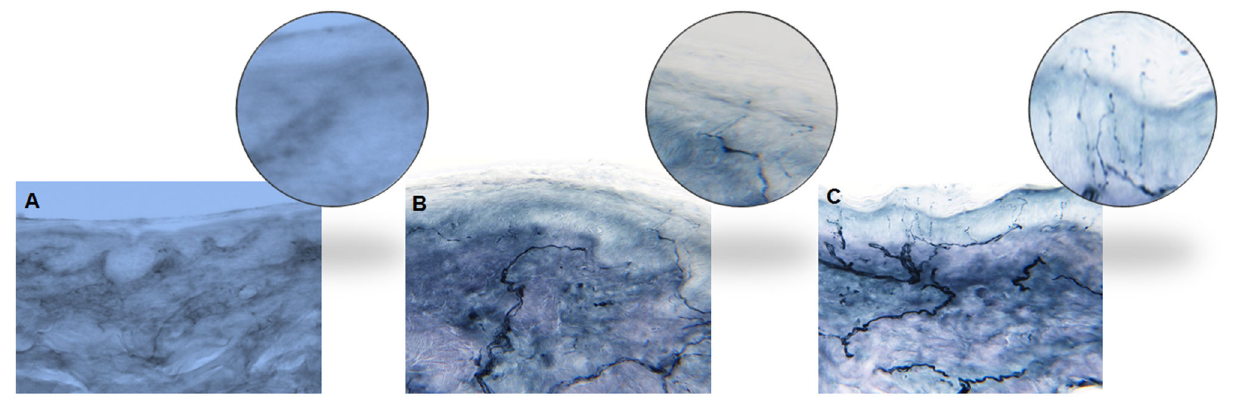
Figure 2. Immunohistochemical staining at Day 75 and 100. (A) Lack of PGP9.5 staining at Day 75 demonstrating complete denervation. (B) Axonal sprouts visualized in a 3 mm punch biopsy 0.5 cm from skin margin at Day 100. (C) Native skin adjacent to flap demonstrating dense intra-epidermal axons.